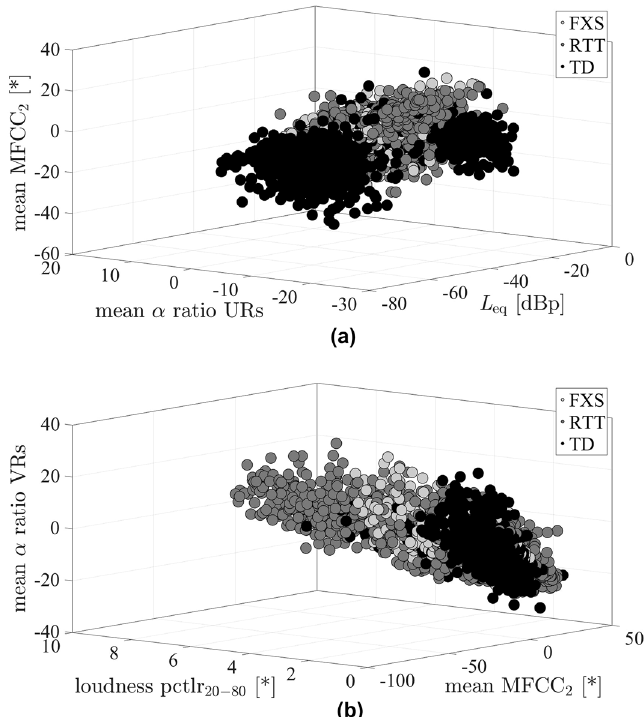
Figure 1. Vocalisation distributions for the paradigm FXS vs RTT vs TD within the space of the three best ranked acoustic features for ( a ) the vocalisation-wise and ( b ) the infant-wise evaluation scenario, respectively (see Table 3), in best system configuration, i.e., without audio and feature normalisation (see Table 2). dBp power converted to decibel with 10 × log 10 ( x ) , FXS, fragile X syndrome, L eq , equivalent sound level, MFCC 2 , second Mel-frequency cepstral coefficient, pctlr, percentile range, RTT, Rett syndrome; TD, typical development; URs, unvoiced regions; VRs, voiced regions; *Real measurement unit not existent as feature values refer to the amplitude of the digital audio